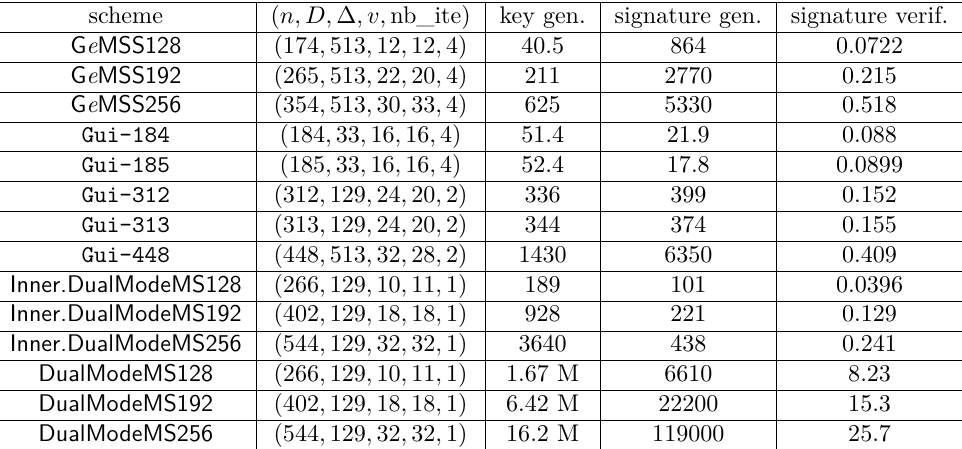
Table 31: Number of mega cycles for each cryptographic operation with MQsoft . We use a Haswell processor (DesktopH).